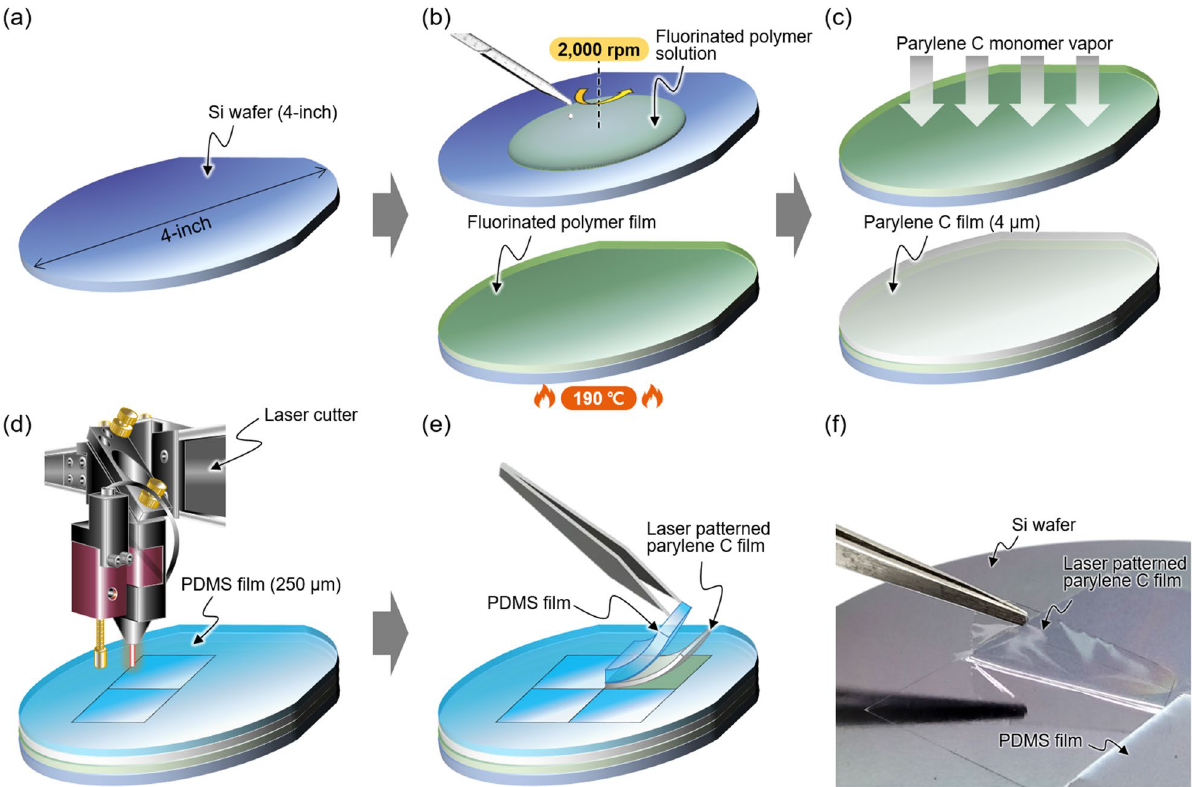
Figure 3. Parylene C substrate manufacturing process through laser patterning: ( a ) 4-inch bare silicon wafer, ( b ) spin coating of fluorinated polymer, ( c ) 4 μm thick parylerne C film deposition, ( d ) substrate patterning using laser cutter, and ( e ) peeling off the parylene C substrate. ( f ) Actual photo of the produced parylene C